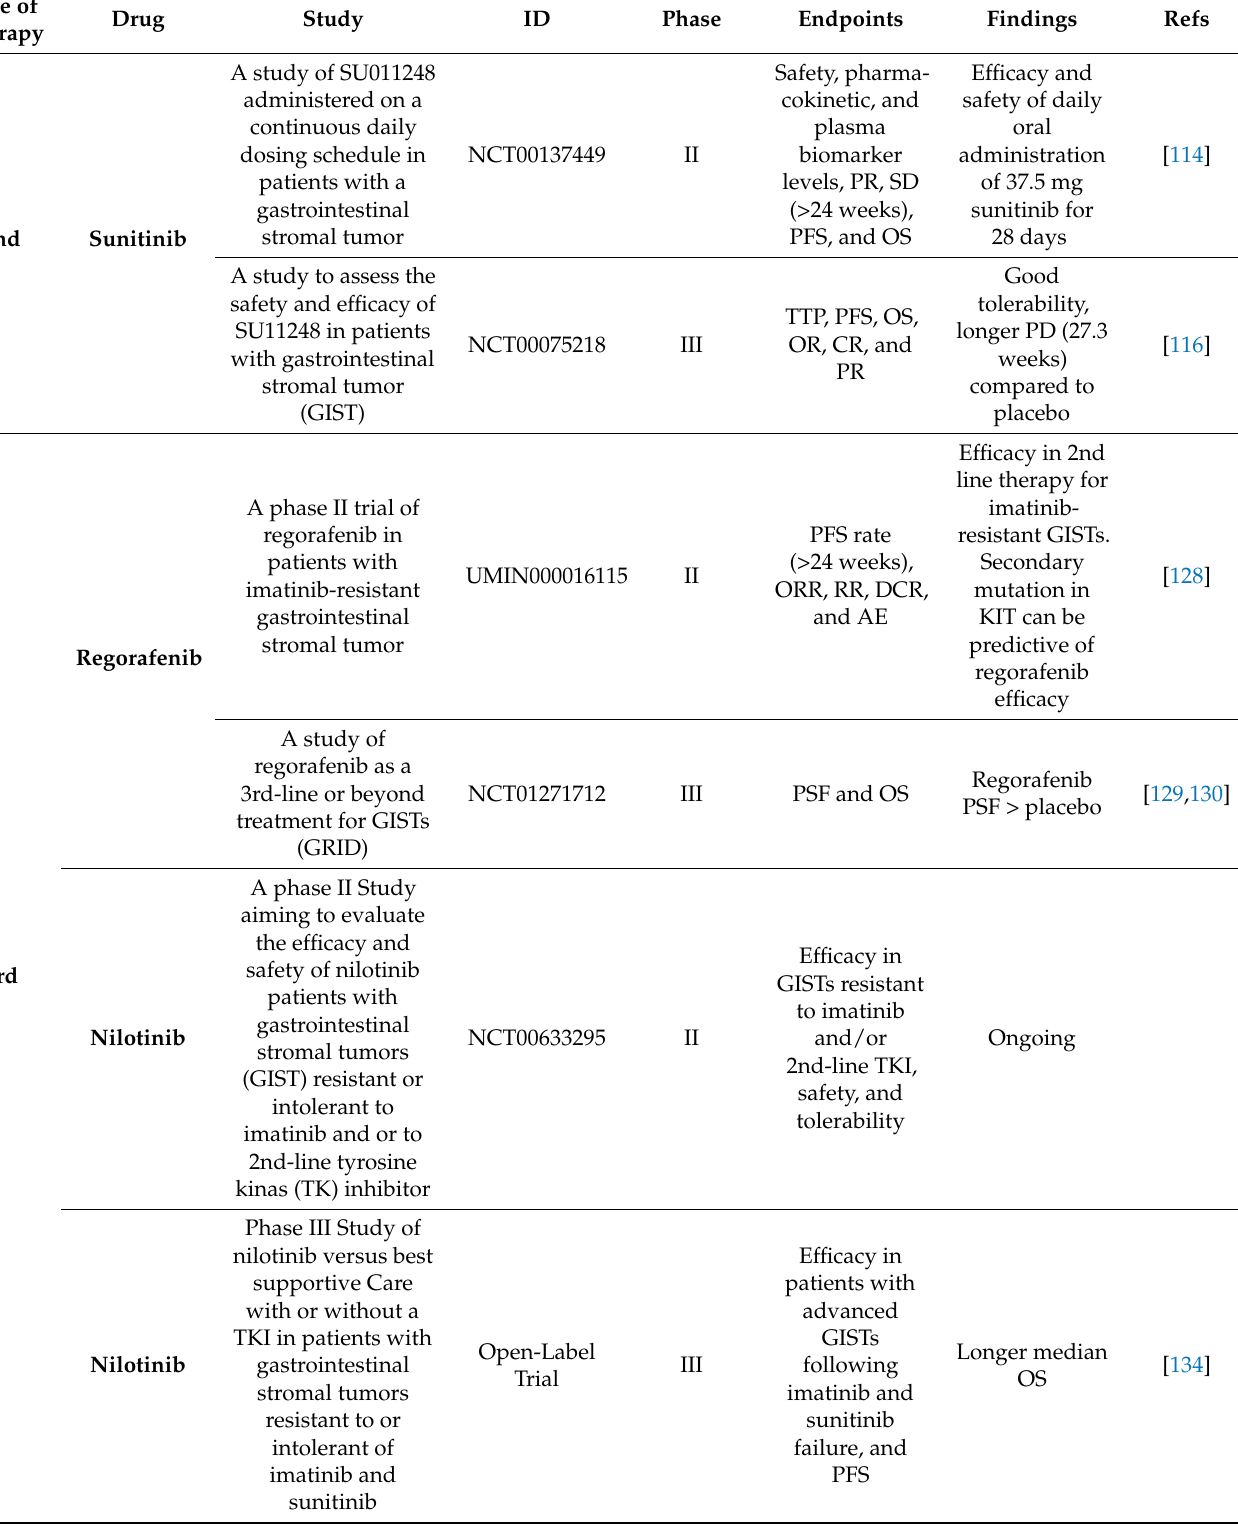
Table 2. Clinical trials evaluating the efficacy of TKIs in imatinib-resistant